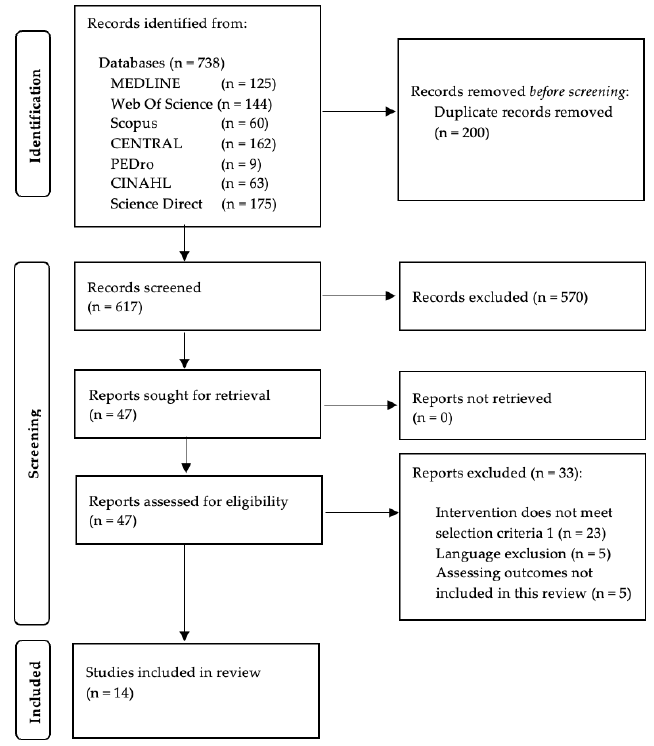
Figure 1. PRISMA flow diagram.